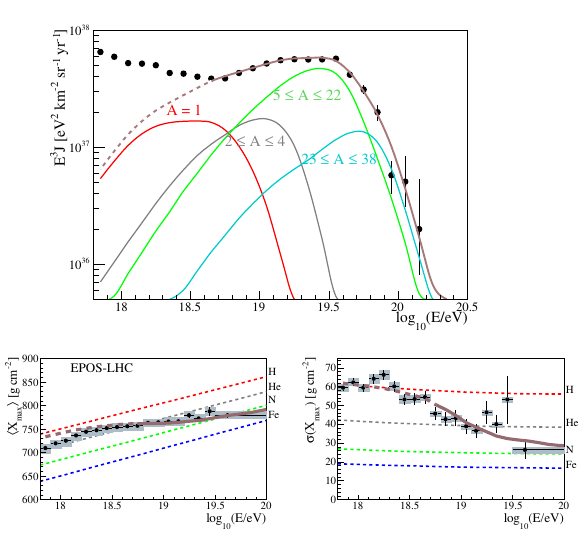
Figure 5. Top: energy spectrum obtained with the best-fit param- eters for the SPG model (SimProp code, PBS photo-production cross-sections, Gilmore ’12 EBL) [23]. Partial spectra are shown with di ↵ erent colors, total spectrum with brown. Full circles show the ICRC 2015 Auger spectrum. Bottom: average and stan- dard deviation of the X max for data [12] (full circles) and best-fit prediction using EPOS-LHC (brown). Pure H (red), He (grey), N (green) and Fe (blue) are shown as dashed lines. Only the energy range where the brown lines are solid is included in the